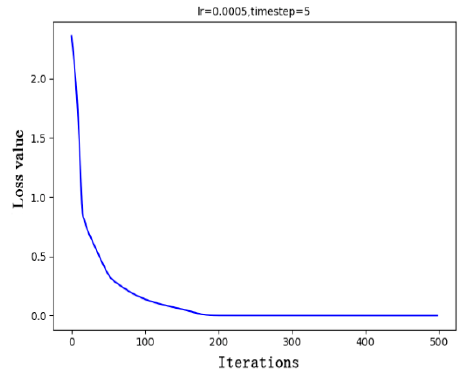
Figure 7. Model convergence process.